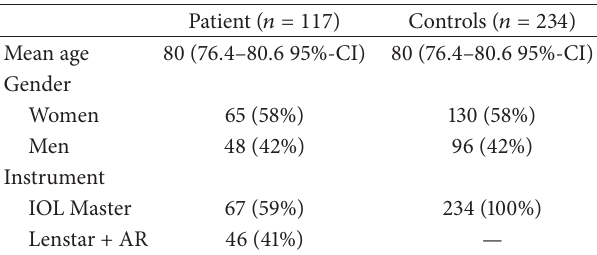
Table1:Demographicsofthestudypopulationandinstrumentused for